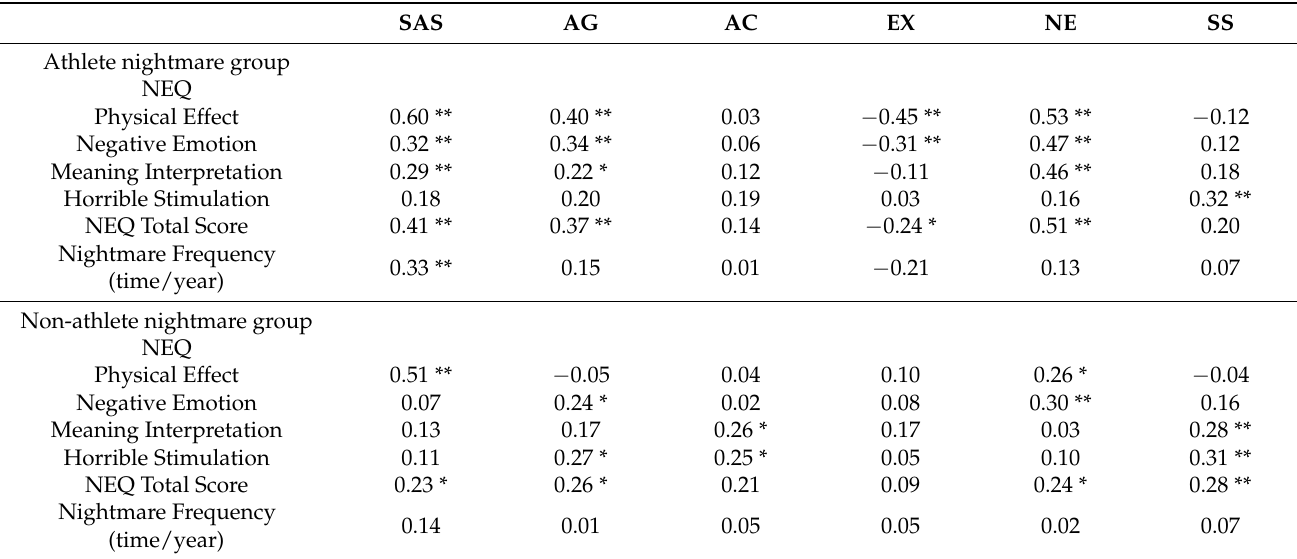
Table 4. Pearson correlation matrix of NEQ, SAS, and ZKA-PQ/SF of the athlete nightmare group (n = 87) and the non-athlete nightmare group (n = 90). SAS AG AC EX NE